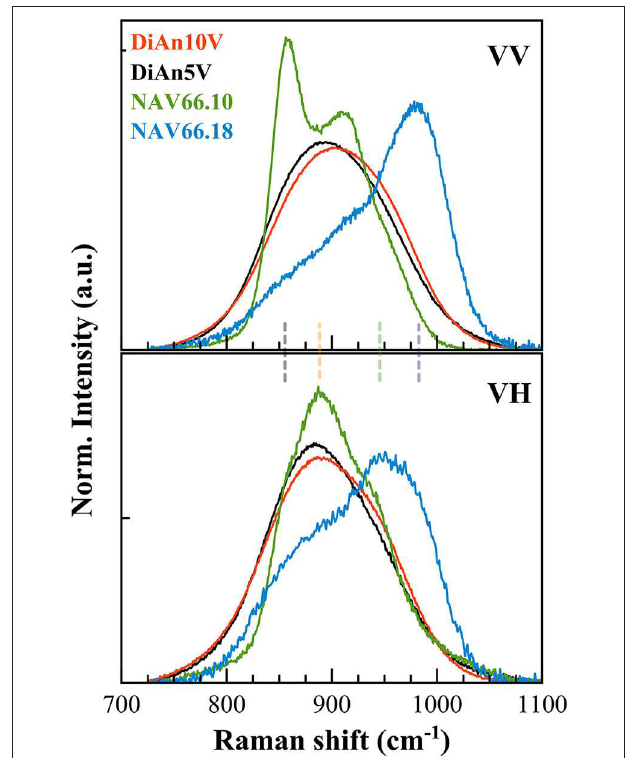
FIGURE 8 | Polarized V signals have been extracted by a direct subtraction of the respective pristine glass signals and normalized on the total area. The extracted spectra highlight the vibrations exclusively coming from V. Four main contributions can be discriminated at ∼ 855, 890, 960, and 985 cm − 1 (vertical dashed lines, as in Figures 7D,E